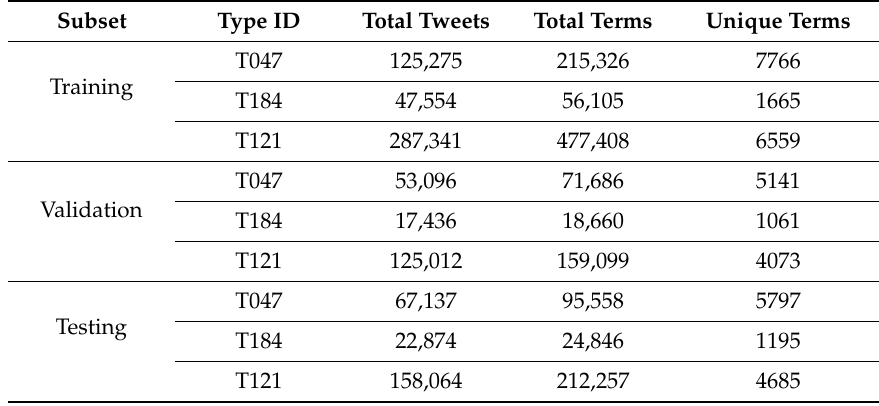
Table 3. Distribution of experimental